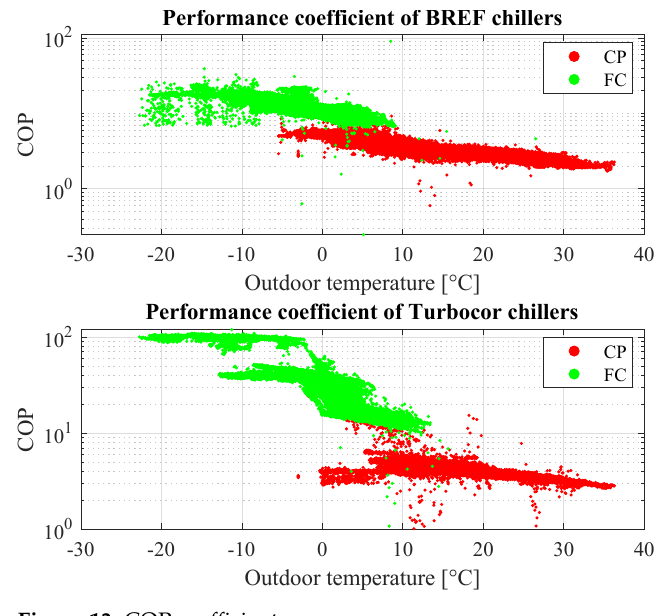
Figure 13. COP coefficient.